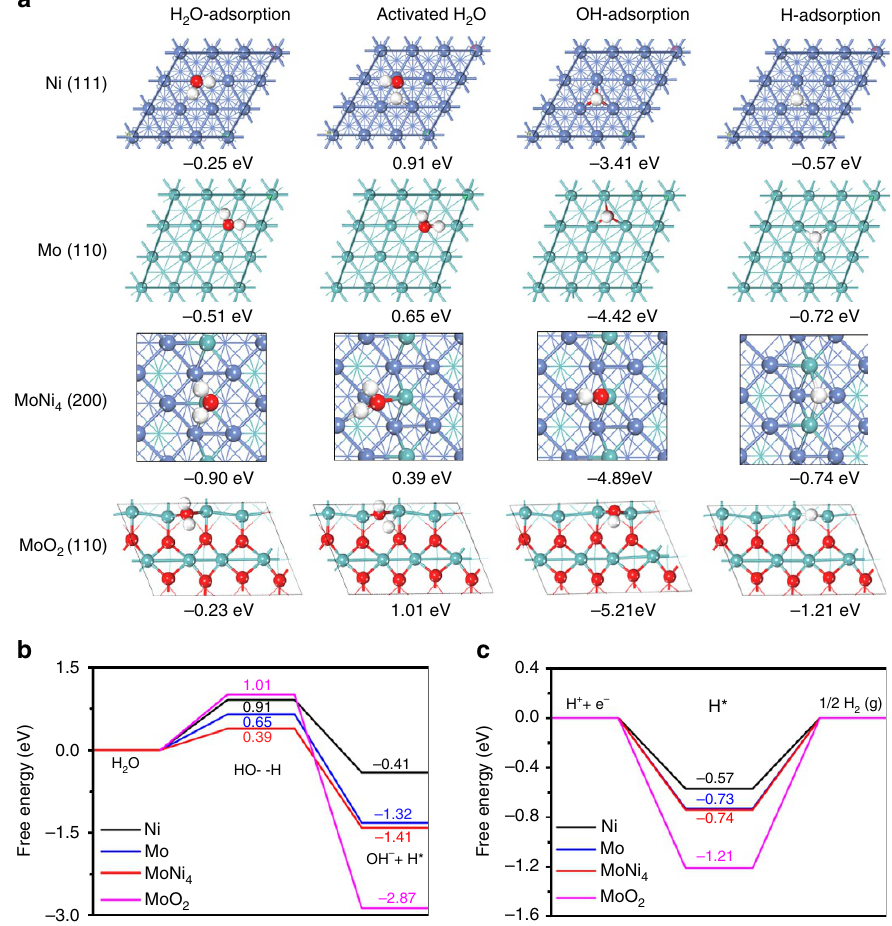
Figure 4 | DFT calculations. ( a ) Calculated free energies of H 2 O adsorption, activated H 2 O adsorption, OH adsorption and H adsorption. ( b ) Calculated adsorption free energy diagram for the Volmer step. ( c ) Calculated adsorption free energy diagram for the Tafel step. Blue balls: Ni; aqua balls: Mo; red balls: